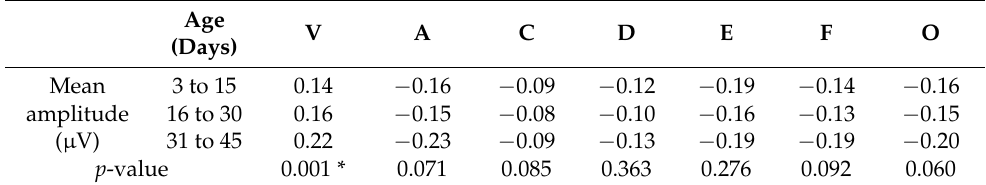
Table 1. Amplitude ( μ V) of the Frequency Following Response waves in the first days of life ( n = 80).